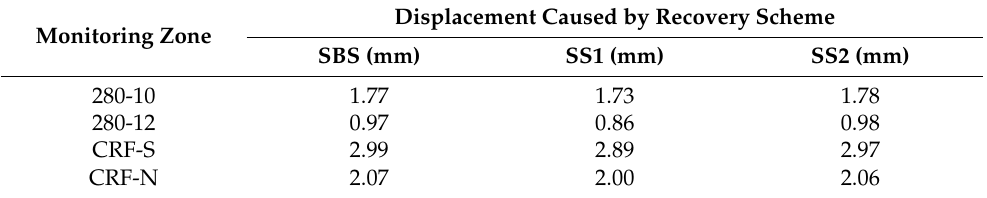
Table 3. Sill pillar recovery induced displacement at monitoring zones.